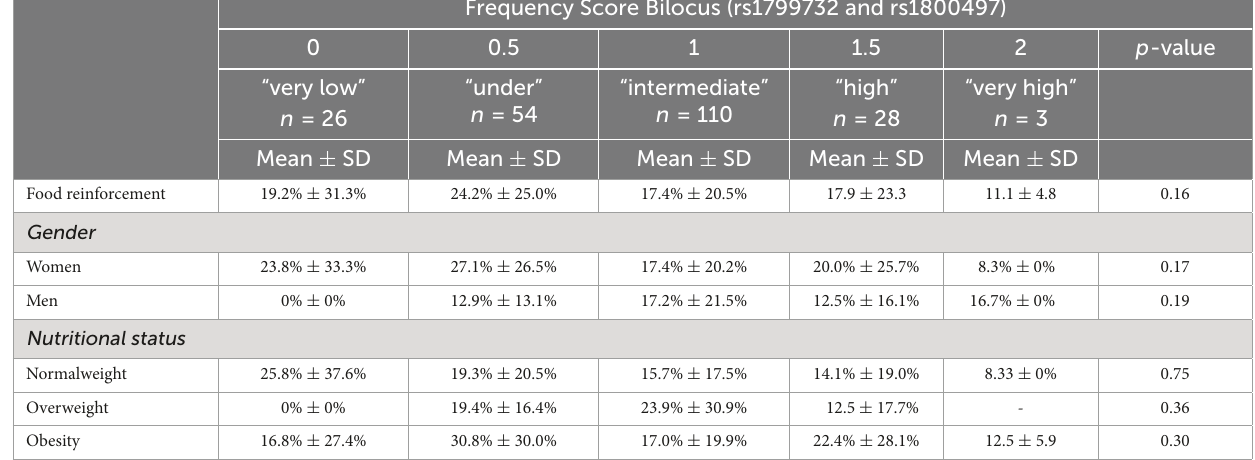
TABLE 5 Food reinforcement by Score Bilocus (rs1799732 and rs1800497), nutritional status and gender in Chilean university